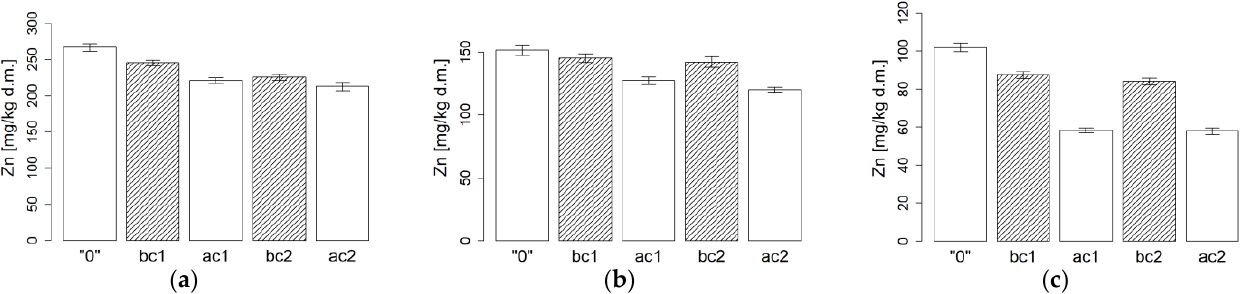
Figure 7. Influence of brown coal and activated carbon on zinc concentrations (after DTPA extraction) in soils, ( a ) 1:1 ratio; ( b ) 1:3 ratio; ( c ) 1:7 ratio.